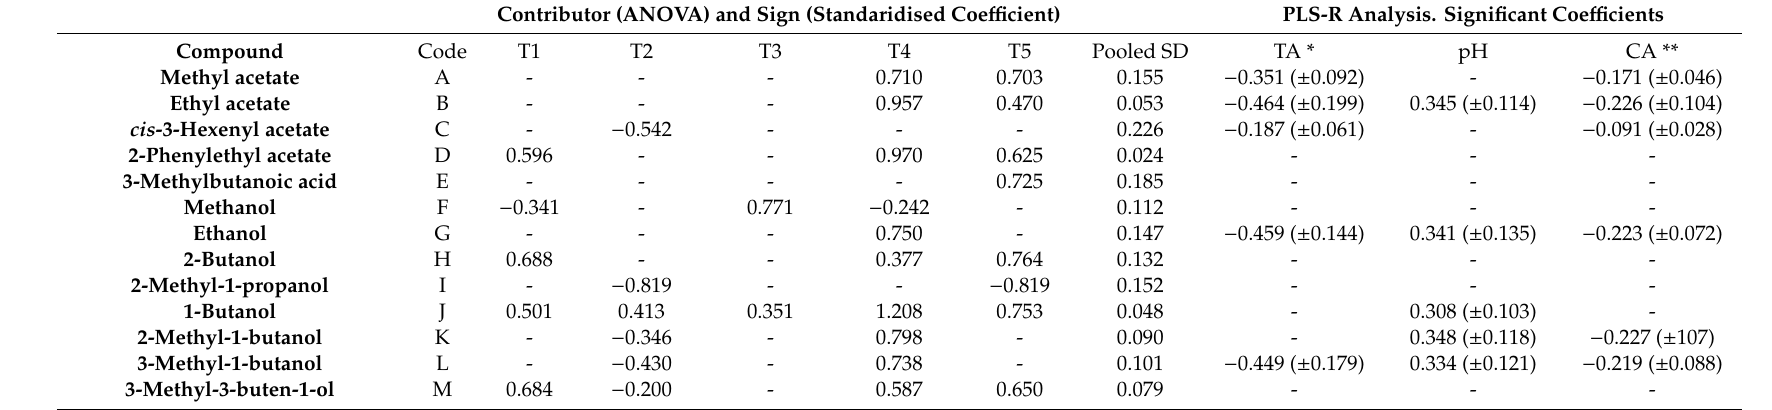
Table 2. Contribution of treatments (inoculation with di ff erent LAB and yeast species) to the production of the di ff erent VOCs found in brine at the end of the fermentation as assessed by their standardized e ff ects. Only 71 significant compounds (from a total of 131) with di ff erences between at least two treatments were used for these analyses. Contribution of treatments for the di ff erent VOCs was compared with respect to the spontaneous fermentation (T6). T1 stands for treatment inoculated with LPG1, T2 with Lp13, T3 with Lpl15, T4 with Y12, and T5 with Y12 + LPG1 + Lp13 +